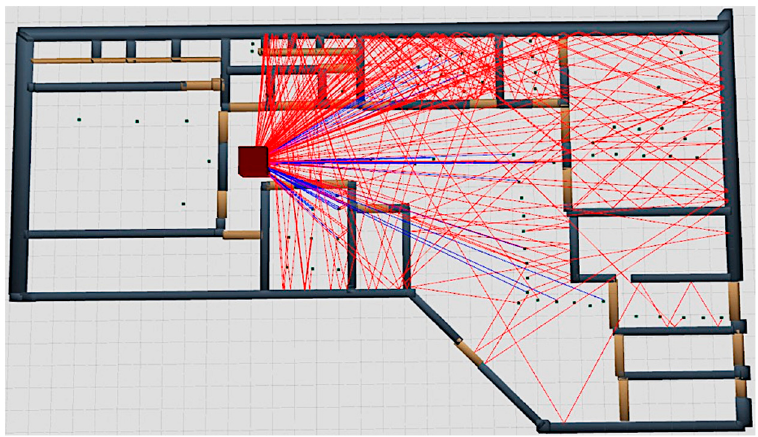
Figure 9. 3-D RT simulation of WCC P15a layout using proposed method.